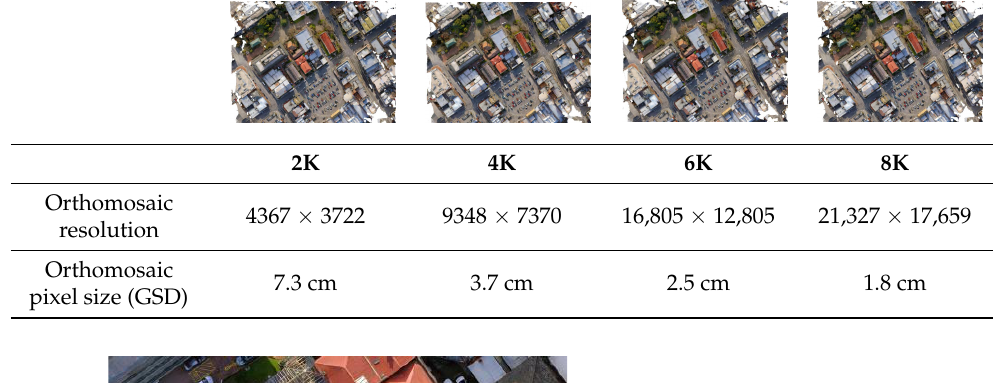
Figure 9. The road mark writing at a garage entrance in the four video resolutions 2K, 4K, 6K, and 8K created orthoimages.